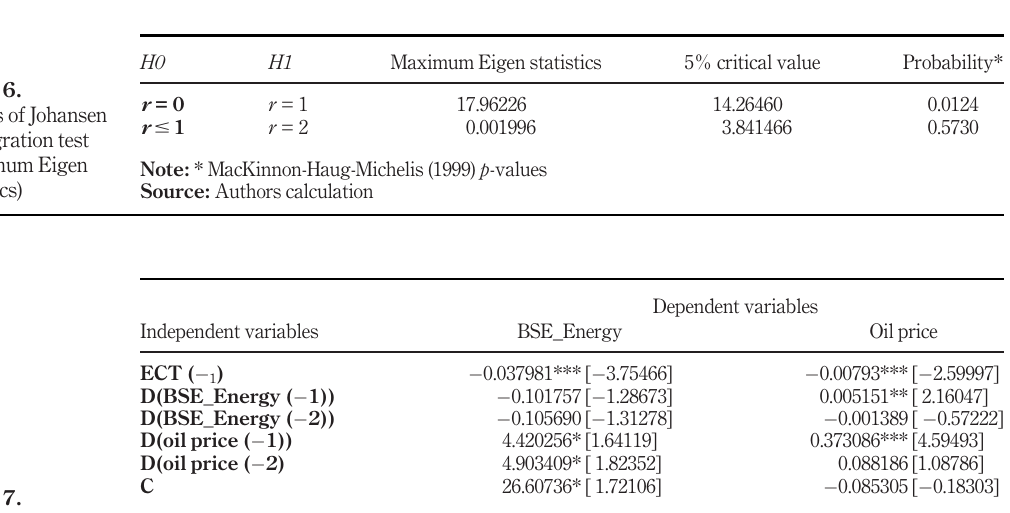
Table 7. Results of the